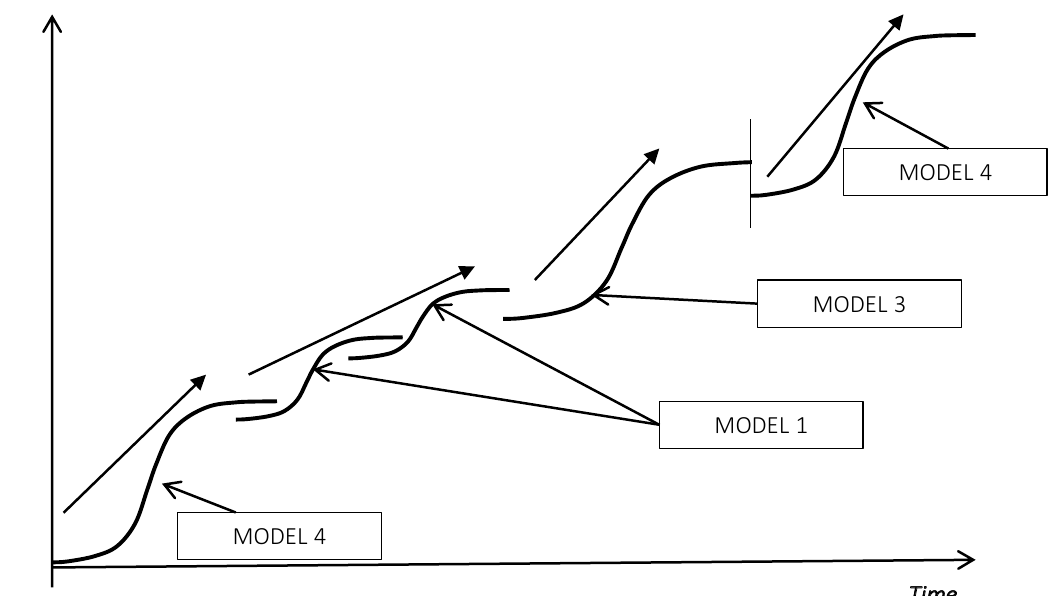
Figure 6. Synergy of innovative models of the first circle of the prognostic